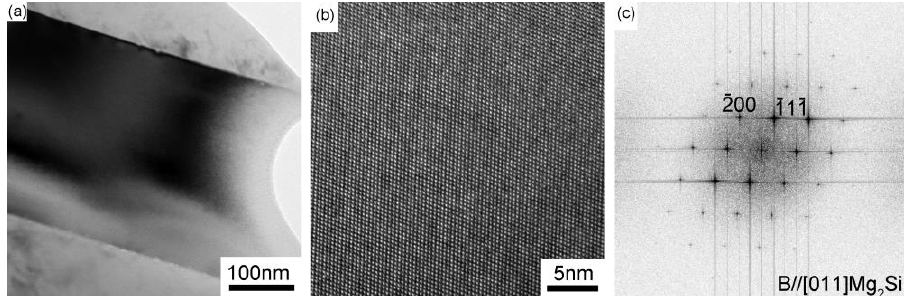
Figure 12. ( a ) The presence of Al 2 Si 2 Ca intermetallic in the Al-Mg-Si alloy system containing 500 ppm Ca. ( b – e ) The corresponding EDS elemental maps, while ( f ) the EDS taken from the location, as shown in ( a ). It should be noted that, at the higher levels of Ca, the morphology of Mg 2 Si is changed from fibers or globules to a block/or plate. ( g ) A schematic diagram, showing the presence of Al 2 Si 2 Ca on the growing interfaces of the eutectic Mg 2 Si phase.